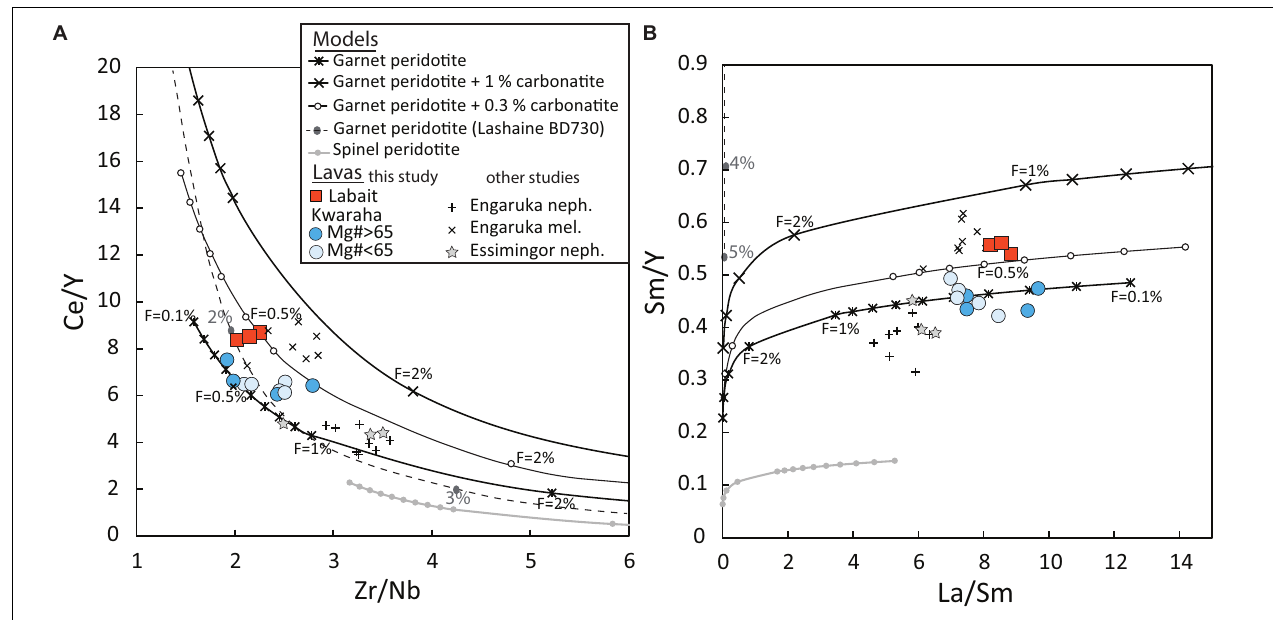
FIGURE 9 | Geochemical model of primary mantle melting for Kwaraha and Labait lavas using (A) Ce/Y vs. Zr/Nb ratios and (B) Sm/Y vs. La/Sm ratios. Partial melting of a garnet peridotite (62% olivine, 16% opx, 10% clinopyroxene, 10% garnet, and 2% phlogopite), spinel peridotite and garnet peridotites with the addition of 0.3 and 1% carbonatite (Kw1 composition) was modeled with no modal fractional melting. Partial melting of a garnet-bearing xenolith from Lashaine volcano (sample BD730 from Gibson et al., 2013) has also been modeled. The degree of melting (F) is indicated for each composition. Nephelinites (neph.) and melilitites (mel.) from Engaruka-Natron basin (Mattsson et al., 2013) and nephelinites from Essimingor (Mana et al., 2012) are also reported. Mafic nephelinites from Kwaraha (Mg# > 65) are reported in blue circles, and less mafic lavas from Kwaraha (Mg# < 65, Table 1 ) are reported in light blue